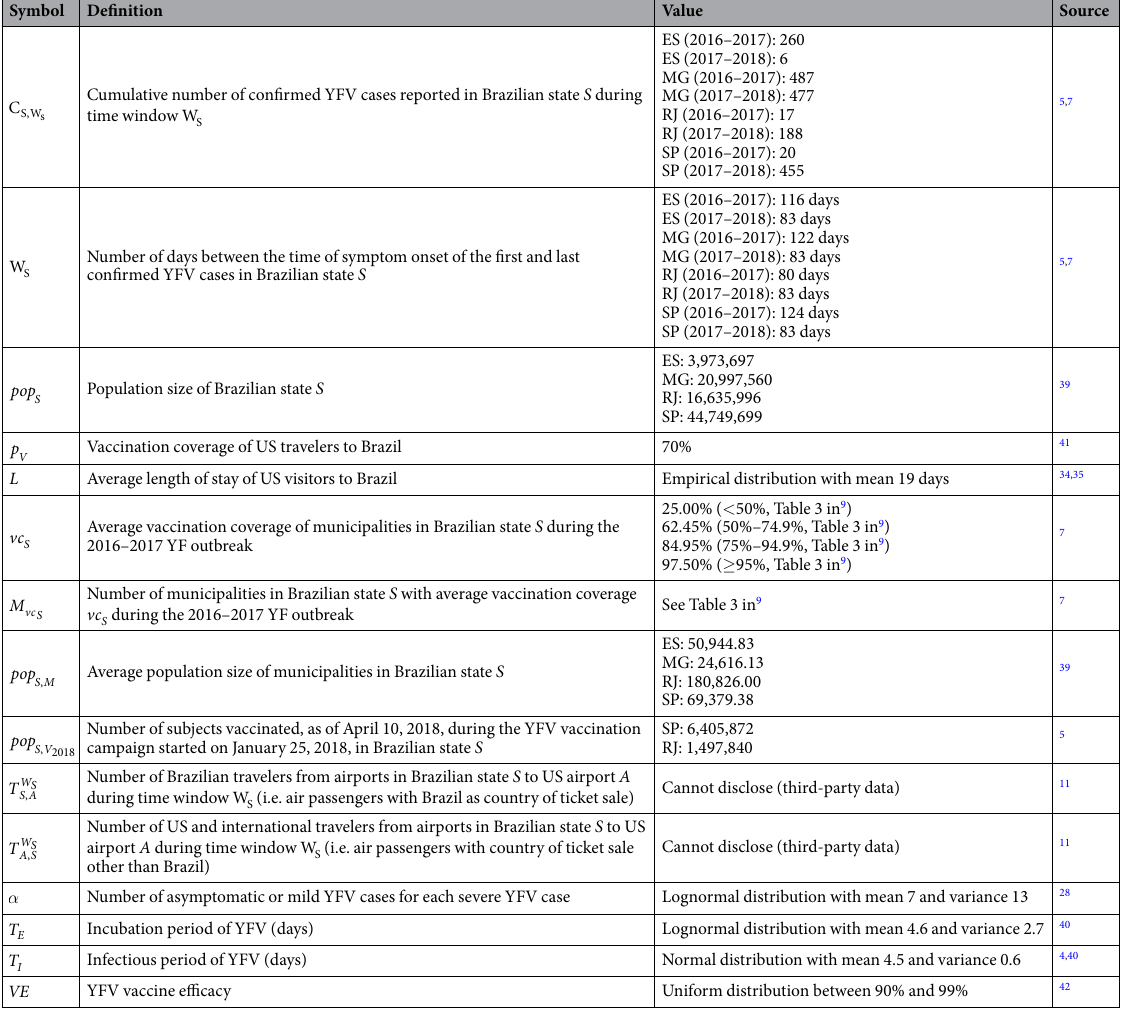
Table 1. Summary of notation, data, and sources used. “ES” denotes Espírito Santo, “MG” denotes Minas Gerais, “SP” denotes São Paulo, and “RJ” denotes Rio de Janeiro. Values not listed in this table are located in the Supplementary Information. We are unable to share air passenger data because they are